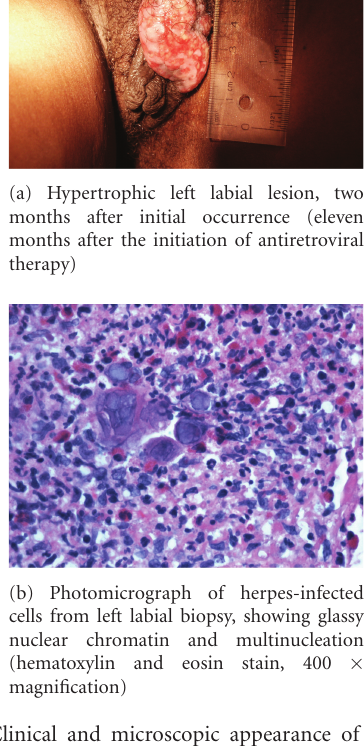
Figure 1: Clinical and microscopic appearance of hypertrophic HSV-2